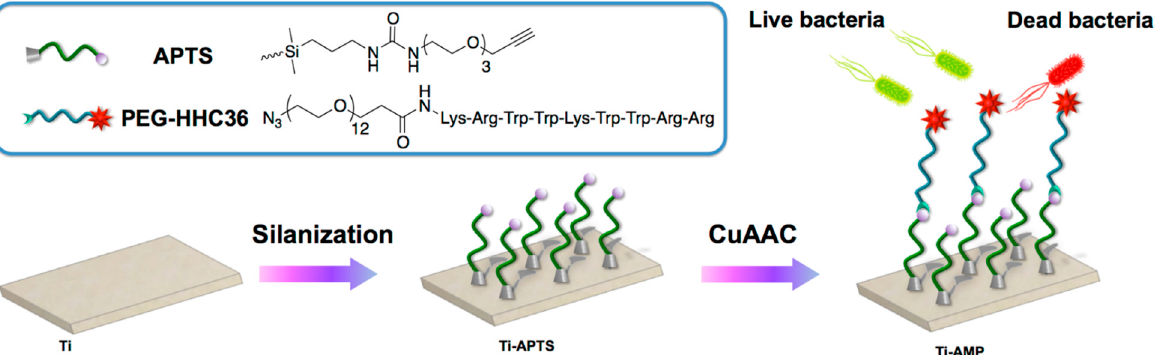
Figure 8. Schematic illustration of the CuAAC click chemistry on the titanium surface. Reproduced with permission from [73]. Copyright 2019 American Chemical Society.